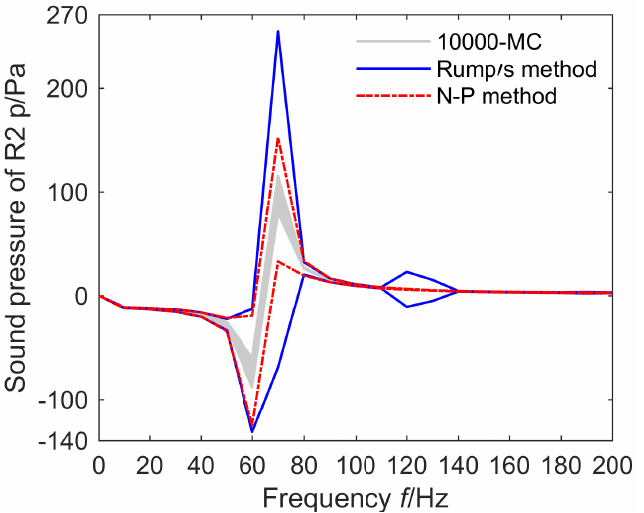
Figure 16. The conservativeness comparison of sound pressure at the point of R2 by Rump’s method and Neumaier–Pownuk